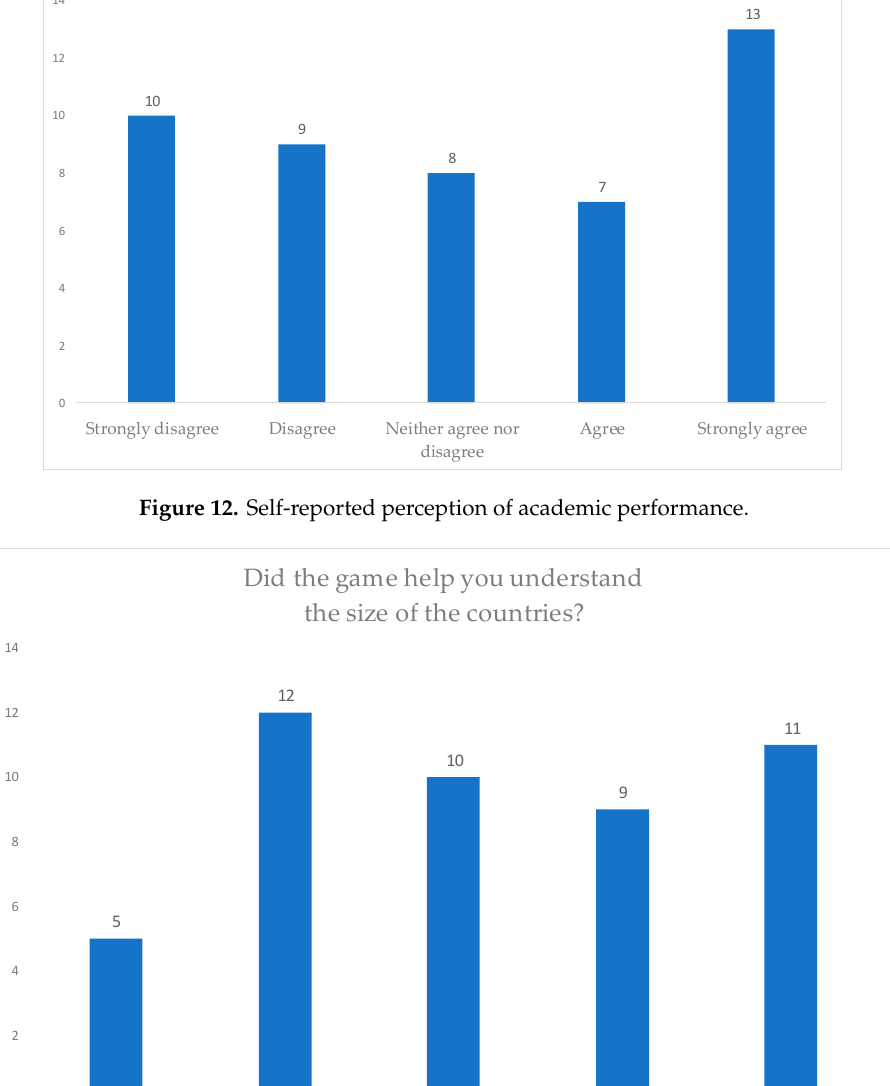
Figure 13. Self-reported effect on learning country size (cf. one of the core mechanics of